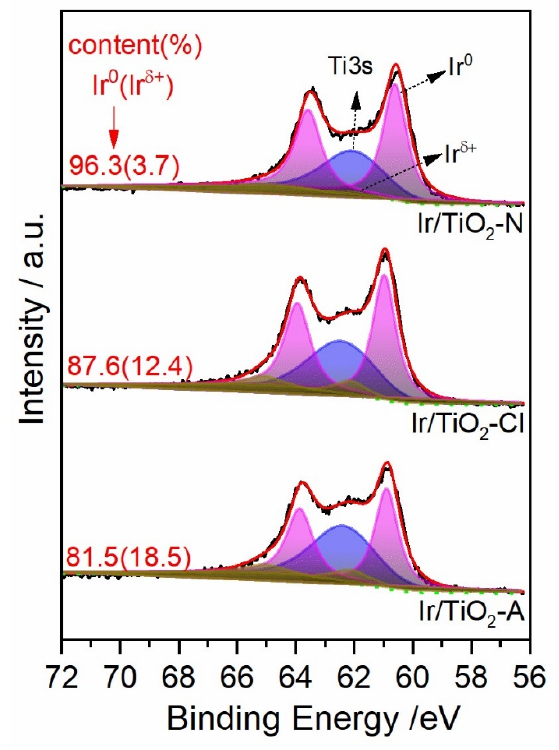
Figure 4. Ir 4f core level XPS spectra of pre-reduced Ir/TiO 2 catalysts.